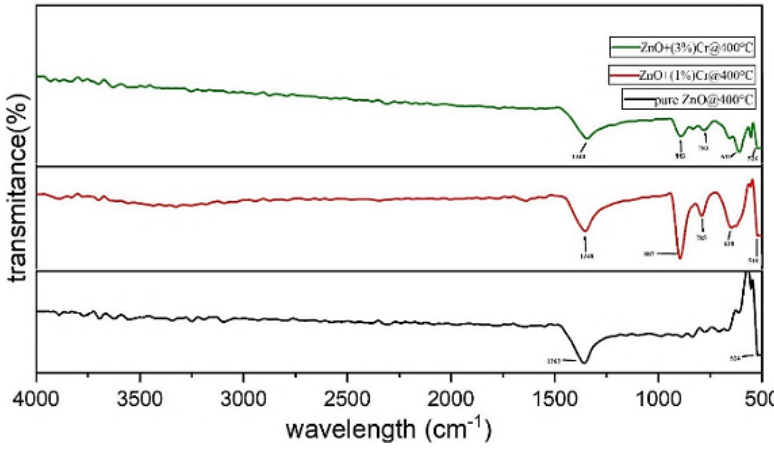
Figure 3. FTIR spectra of Zn (1-x) Cr x O (x = 0, 0.1 and 0.3) nanoparticles.